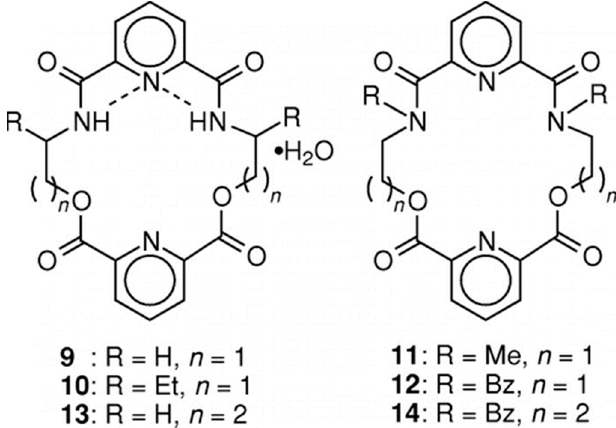
Figure 8. Pyridyl-containing macrocyle ligands for Ag + . Reprinted with permission from Reference [53]. Copyright (1996) American Chemical Society.